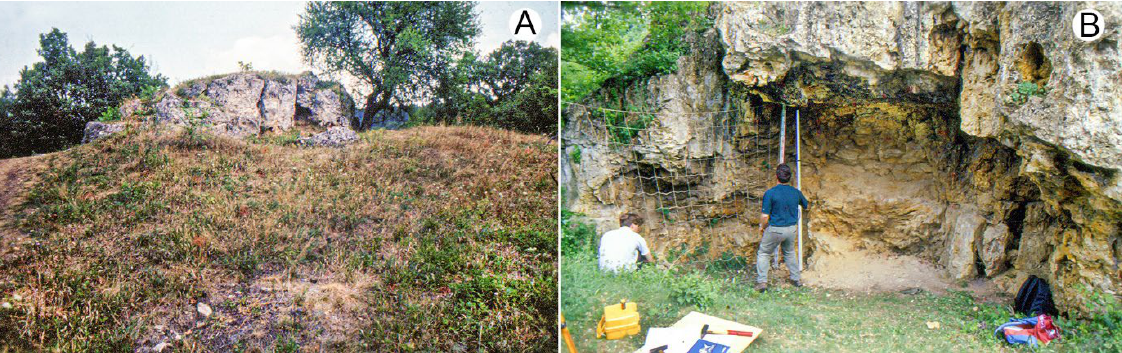
Figure 11. ( A ) spring cone, ( B ) exposed cavity (Tihany Peninsula).